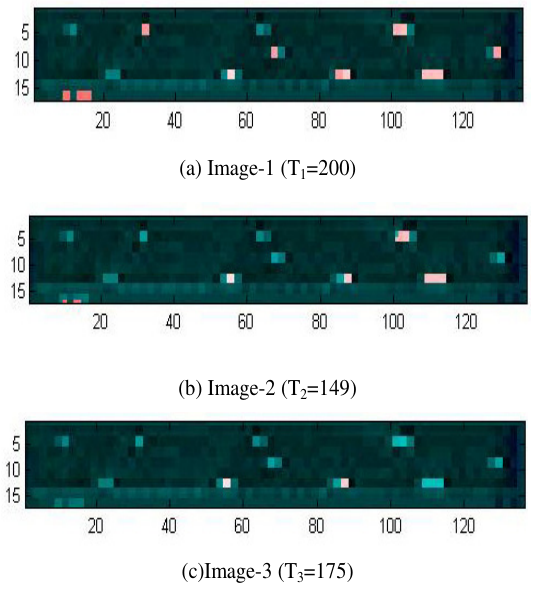
Figure 15: Thresholded